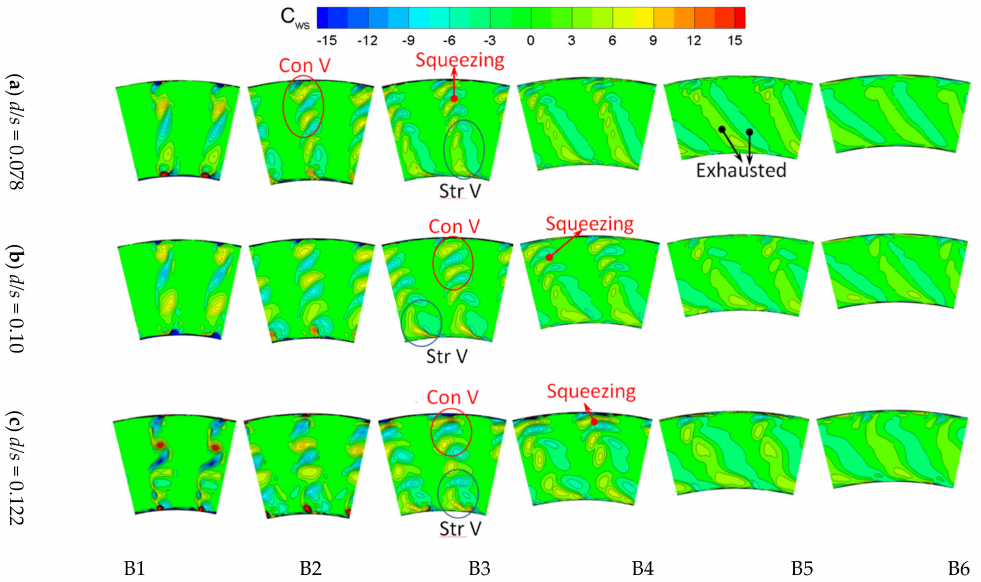
Figure 10. Time-averaged streamwise vorticity contour in different sections of the AITD.